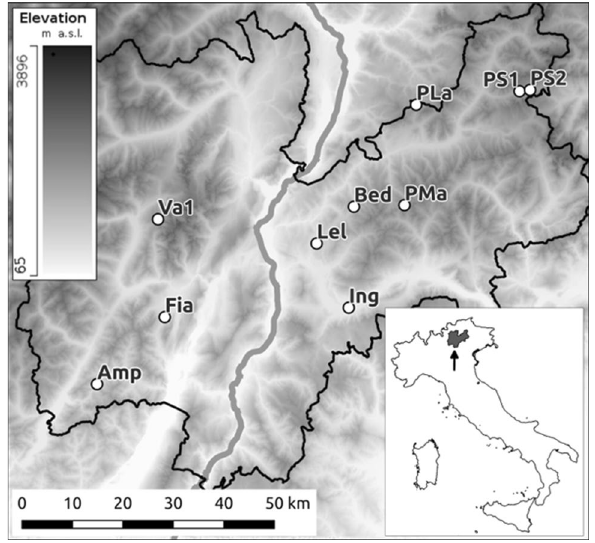
Figure 1. Map of the study region (Province of Trento, Italy) showing the 10 selected wetland sample sites, labeled according to Table 1. Site locations, abbreviations, coordinates, elevation and description are listed in Supplementary Information, Table S1. The map was generated using QGIS version 3.20 (http:// www. qgis. org); Digital Terrain Model (DTM) for the study area was extracted from the 20 m-resolution DTM of Italy, publicly